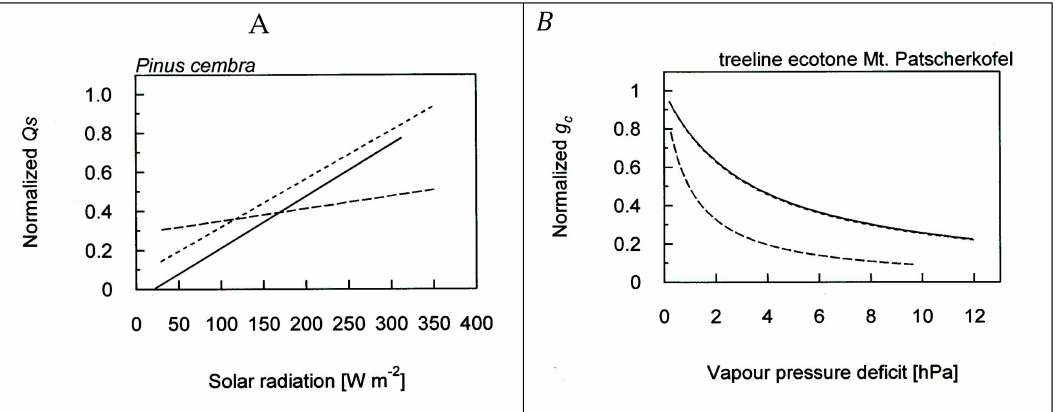
Figure 3. The relationship between ( A ) solar radiation and daily mean normalized sap flow density (Qs) and ( B ) between vapor pressure deficit and normalized daily mean crown conductance (g c ) of Pinus cembra at the krummholz limit (dashed lines), the treeline (dotted lines), and the forest limit (solid lines). After